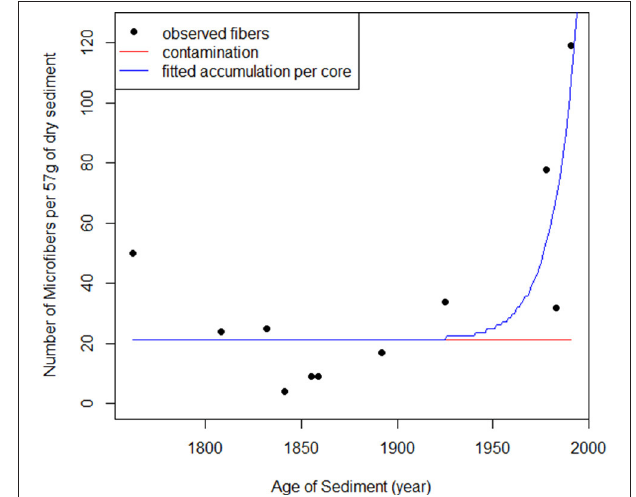
FIGURE 4 | The number of observed micro fibers in the sediment cores through time (black dots) (y = 0.6793x + 21.1055) compared to the predicted accumulation of micro fibers in the sediment through time (blue line) (y = 1.208x + 21.294). The predicted values are estimated from the global plastic production values. The red line is the constant level of micro fiber contamination throughout time (y = 21.294). As plastic production did not start until the 1950s, all observed micro fibers pre-1950s are considered